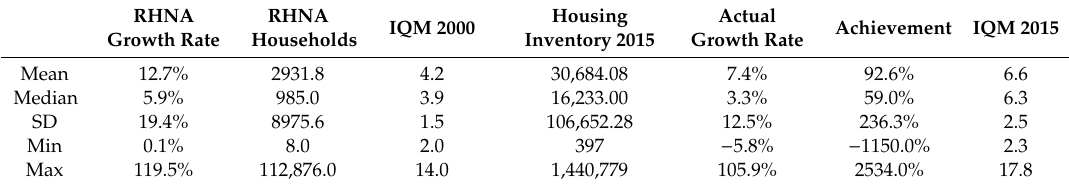
Table 2. The Sample’s Descriptive Statistics. Note. RHNA = regional housing needs allocation; IQM = informal qualification metric. Sources: Southern California Association of